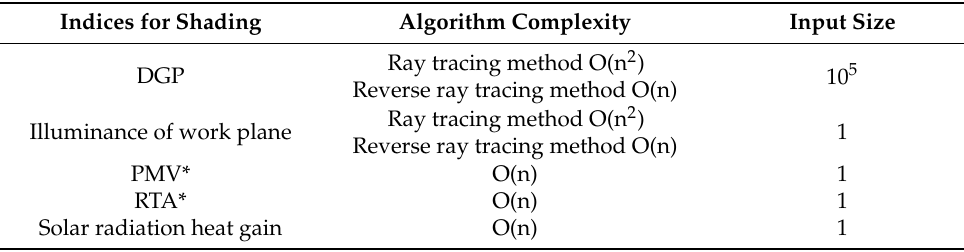
Table 6. Computational complexity of shading control